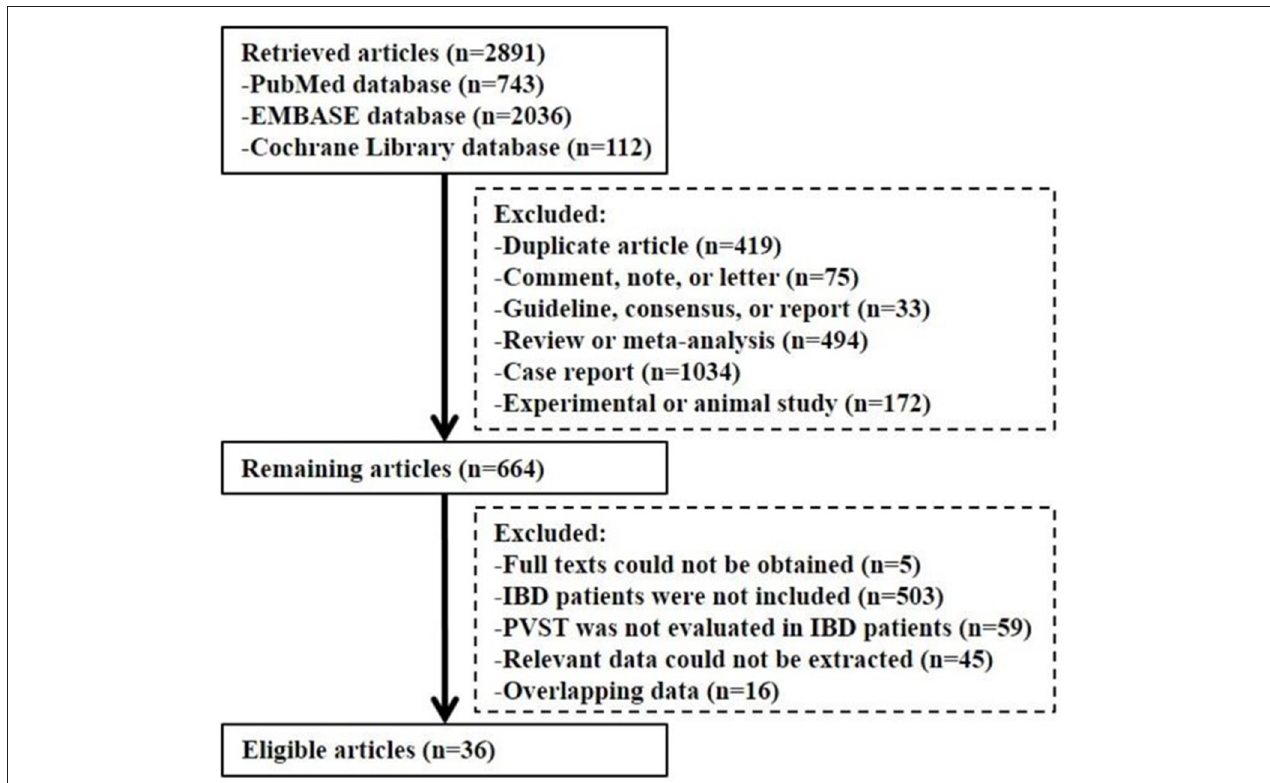
FIGURE 1 | Flowchart of study